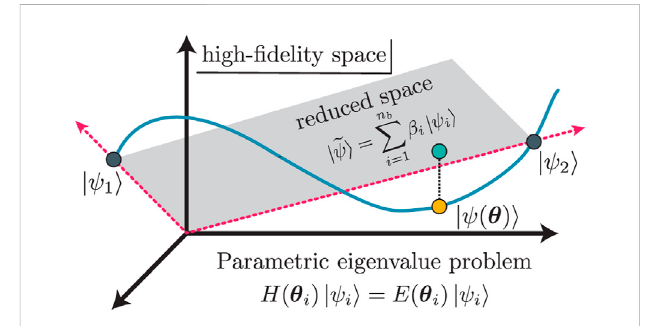
FIGURE 1 Illustration of a projection-based emulator using only two snapshots | ψ i 〉 ≡ | ψ ( θ i ) 〉 (dark gray points). These snapshots are high- fi delity solutions of the Schrödinger Eq. 1, which span the subspace of the reduced-order model, as indicated by the red arrows and the grayplane.Thetrajectoryofahigh- fi delityeigenvectorisdenotedbythe blue curve. The orange dot depicts an eigenvector | ψ ( θ ) 〉 along the trajectory that, when projected onto the reduced space, corresponds to the turquoise point; hence, the difference between the orange and turquoise points represents the error due to the emulator ’ s subspace projection ( i.e. , the dotted line). Inspired by Figure 2.1 in Ref.